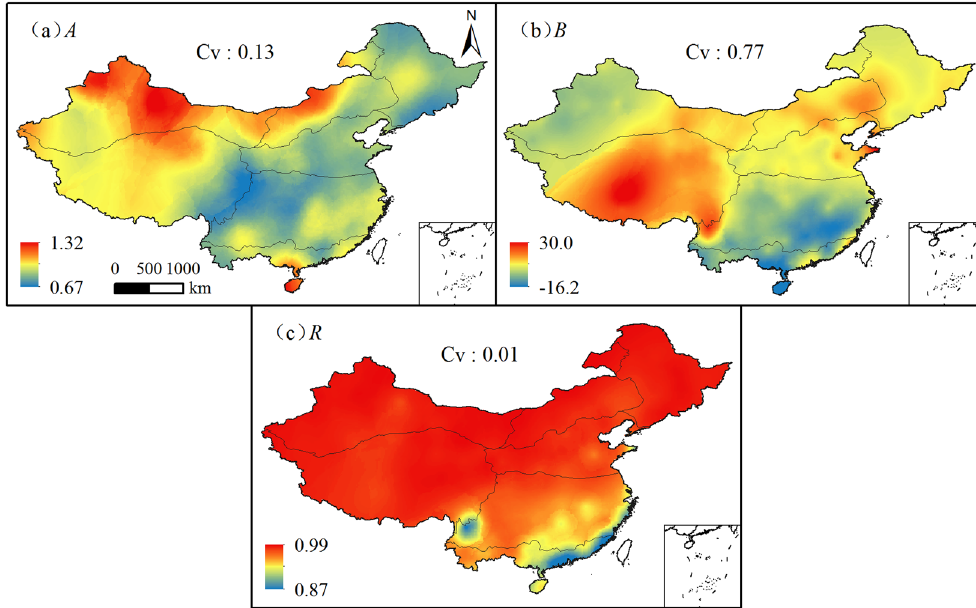
Figure 10. Spatial distributions of the parameters A , B and R in equation 13 in EMC. (ArcGIS 10.2, http://map. baidu.com, Lingling Peng).